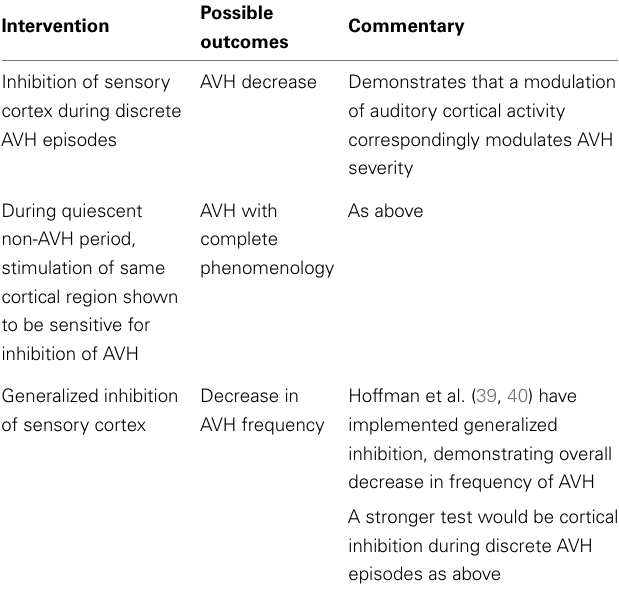
Table 3 |Auditory verbal hallucination mechanisms: testing spontaneous activity account in schizophrenia